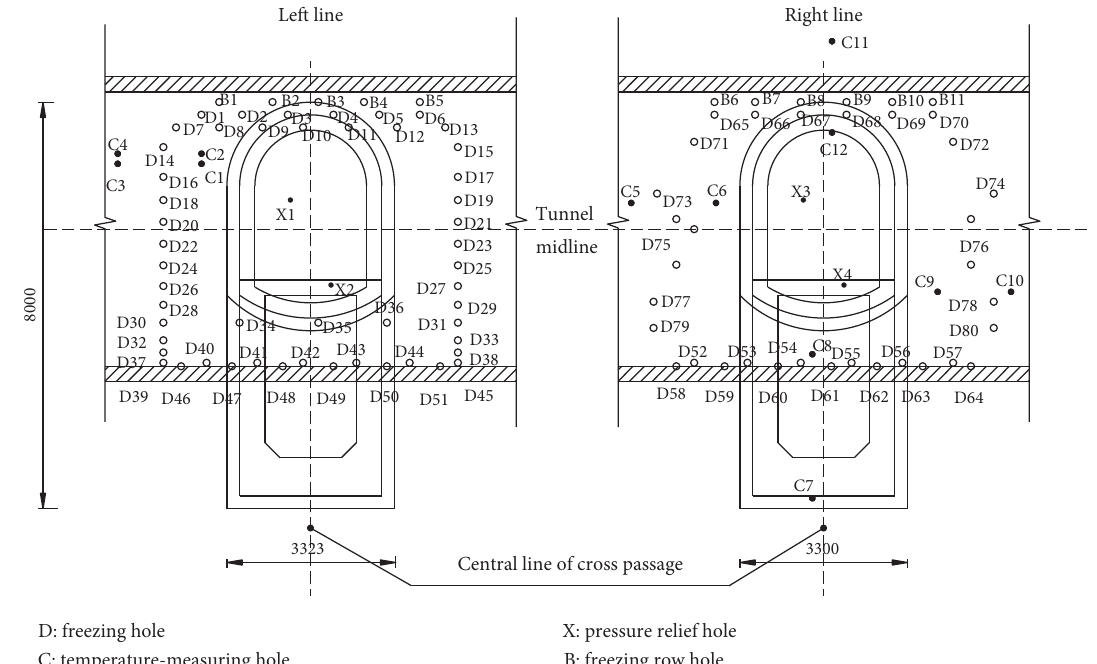
Figure 2: Layout of the freezing holes, temperature-measuring holes, pressure relief holes, and freezing row holes (unit: mm).